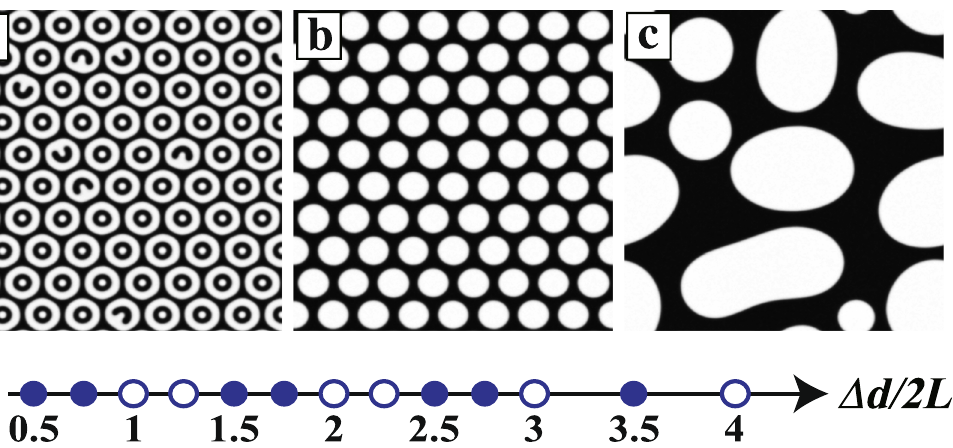
Figure 6. Time evolution of the concentric circle pattern with multiple propagated triggers when Δ d = 60, = 0.5. ( a ) By t = 60, a concentric circle pattern has formed at each core. ( b ) At t = 5000, a φ = 0.1, and v tri hexagonal pattern is observed after coarsening of the concentric circles. ( c ) Finally, at t = 20000, the hexagonal pattern has collapsed due to thermal noise. The final pattern is the inverse of the pattern when Δ d = 60. ( d ) Diagram of the final pattern for different Δ d /2 L . The symbols in ( d ) are the simulated points. A filled circle corresponds to a pattern where droplets of the majority (black) phase form in the minority (white) phase. An open circle corresponds to a pattern where droplets of the minority phase form in the majority phase.